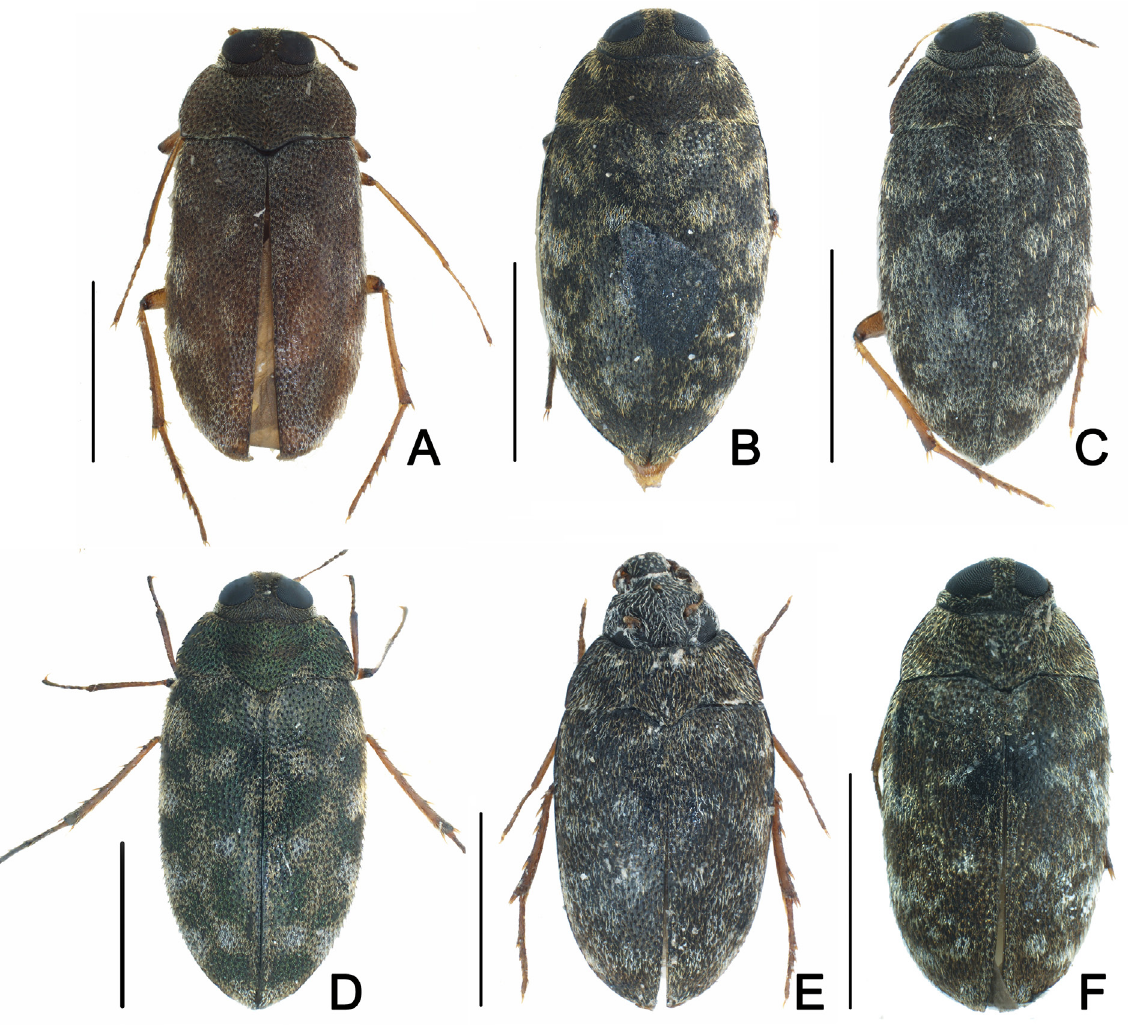
Fig. 5. Acontosceles spp. A . A . borneensis sp. nov., holotype (BPBM). B . A . yorioi Satô, 1966 (EUMJ). C . A . hydroporoides Champion, 1924 (NME). D . A . chujoi Yoshitomi & Satô, 2005 (EUMJ). E . A . siwalikensis Pütz, 2008 (NME). F . A . zetteli Pütz, 2008 (BPBM). Scale bars: